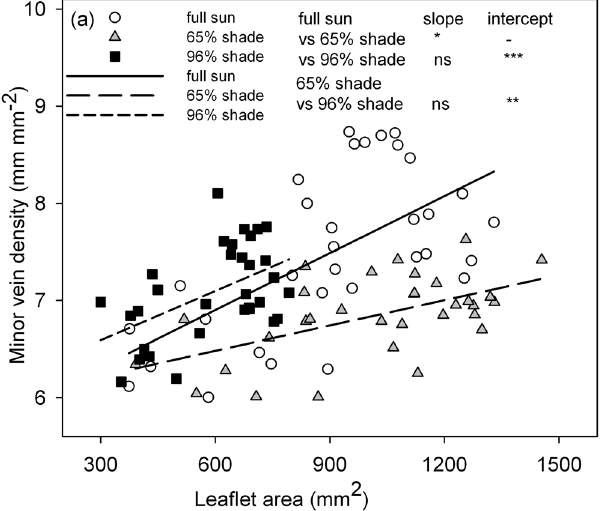
Figure 2. Relationships between leaflet area (LA) and minor vein density (MVD) in peanut plants grown in three light conditions. Each symbol represents one leaflet, and relationships were significant for each light condition (full sun, MVD = 5.7 + 0.002 × LA, r 2 = 0.38 *** ; 65% shade, MVD = 6.0 + 0.001 × LA, r 2 = 0.31 ** ; 96% shade, MVD = 6.1 + 0.002 × LA, r 2 = 0.27 ** ). The differences in linear regression slope and intercept between each pair of lines are indicated. * P < 0.05; ** P < 0.01; *** P < 0.001; ns, P > 0.05.